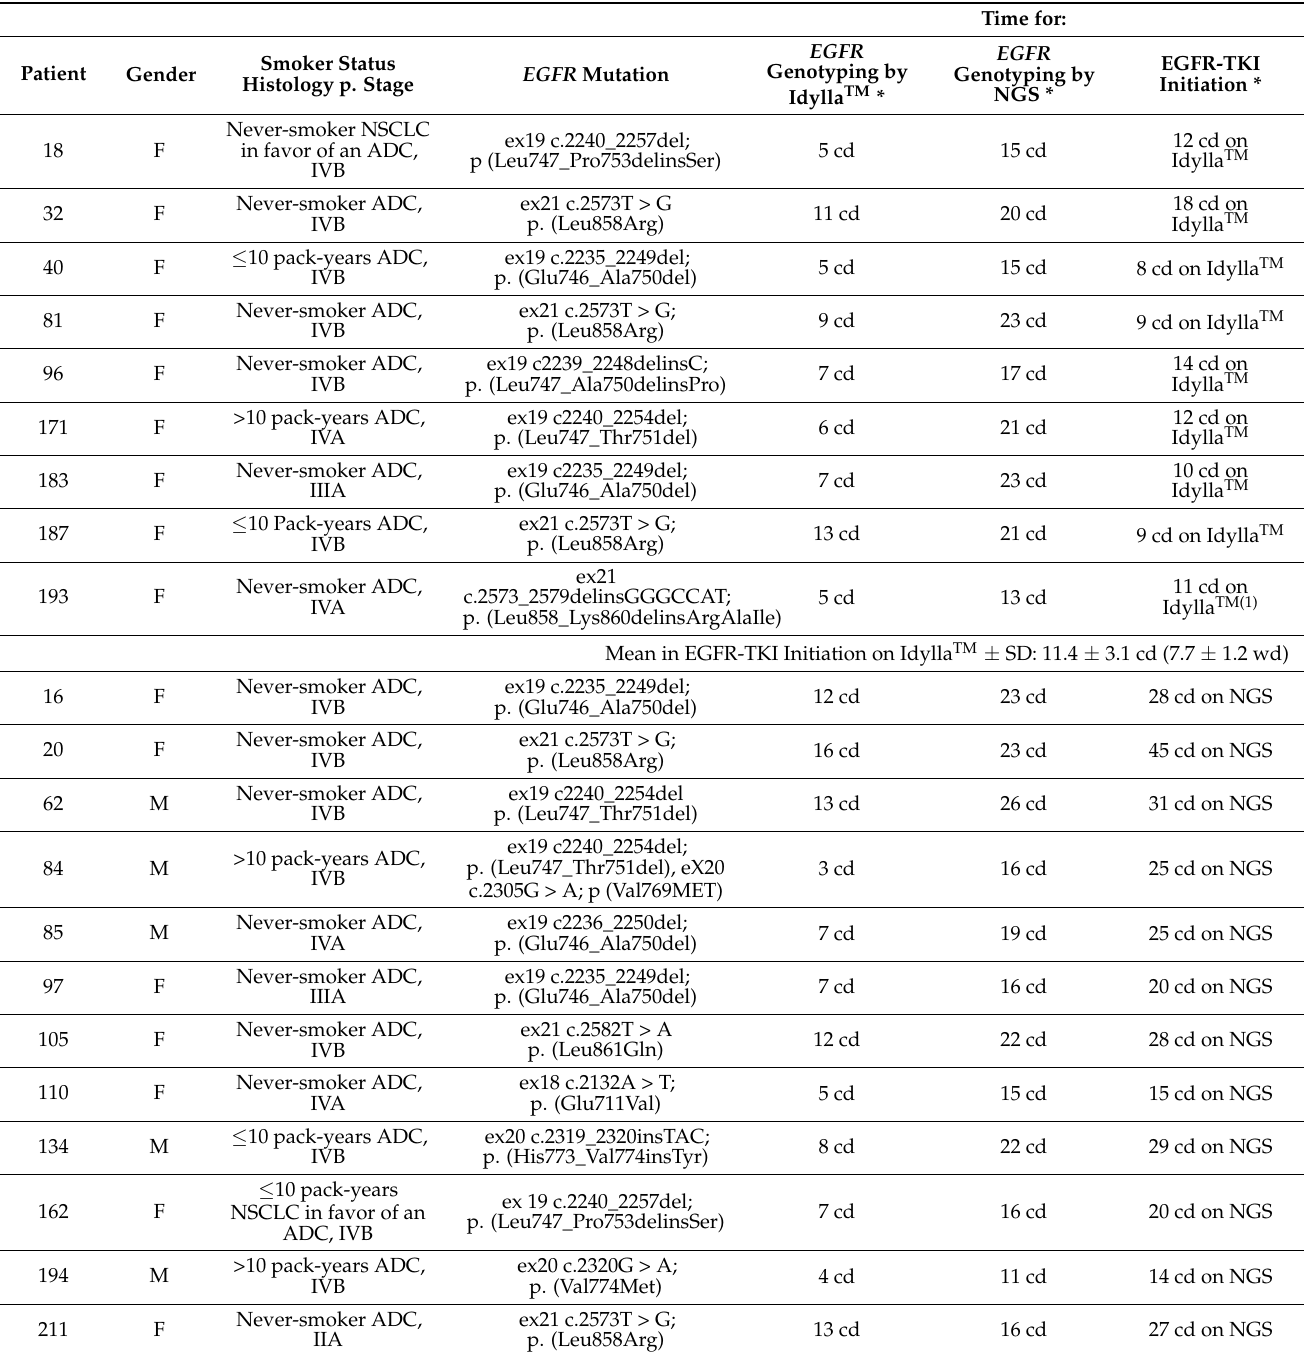
Table 2. Turnaround time of initiation of EGFR-TKI in patients with NSCLC harboring EGFR mutations according to EGFR genotyping by the Idylla TM system or the NGS